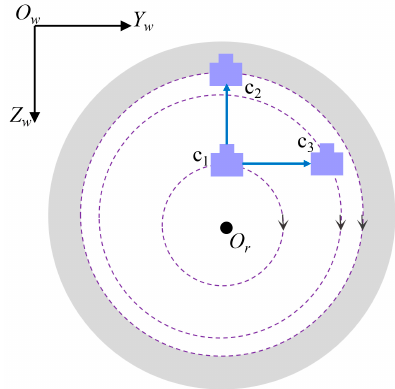
Figure 4. The rotation diagram of the camera placed at positions c 1 , c 2 and c 3 .